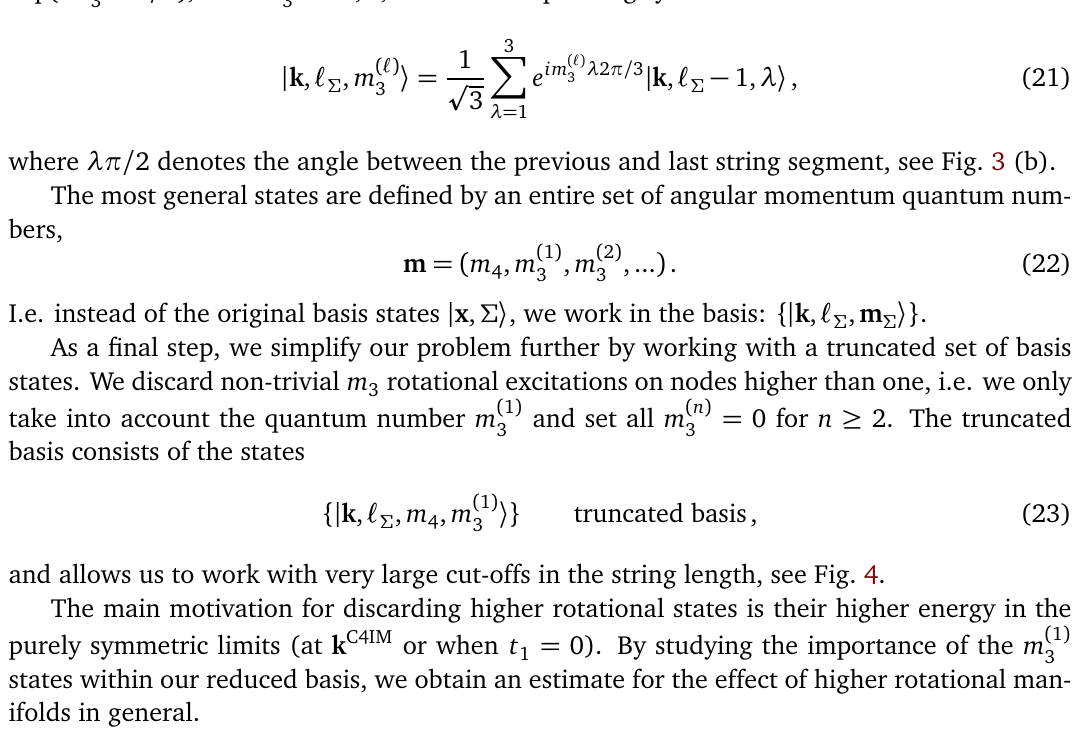
Figure 4: The truncated basis consists of rotational states with m quantum numbers only, defined around the first hole (asymmetric